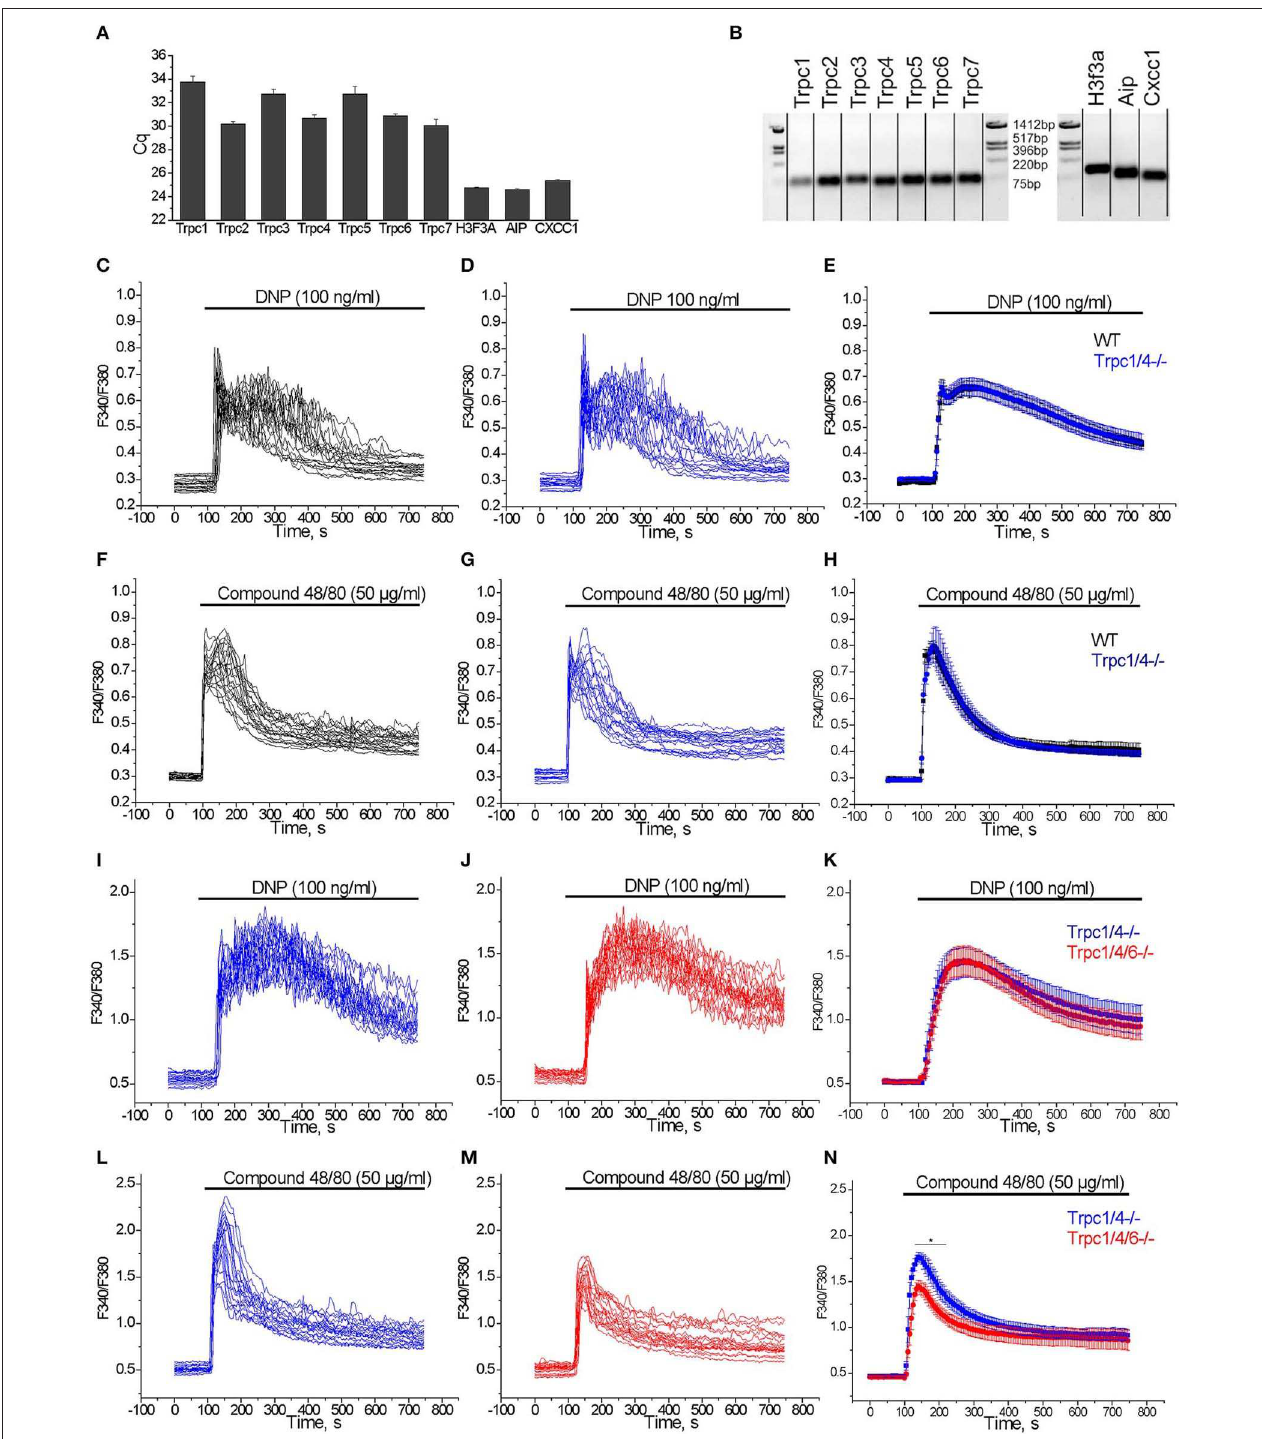
FIGURE 4 | (A) RT-qPCR expression analysis of Trpc transcripts in PMC. Cq values (mean ± S.E.M.) were obtained from duplicates of 3 independent wild type PMC preparations. (B) RT-qPCR end products are visualized by agarose gel (2%) electrophoresis. The amplicons correspond to the calculated sizes: Trpc1- (65 bp), Trpc2- (87 bp), Trpc3- (75 bp), Trpc4- (60 bp), Trpc5- (63 bp), Trpc6- (61 bp), Trpc7- (64 bp), H3f3a - (90 bp), Aip - (86 bp), Cxcc1 - (66 bp). (C–H) Measurements of [Ca 2 + ] i changes performed with Fura-2 presented as F340/F380 fluorescence ratio in PMC isolated from WT (C57Bl6/N, black) and Trpc1/4 − / − (DKO) mice